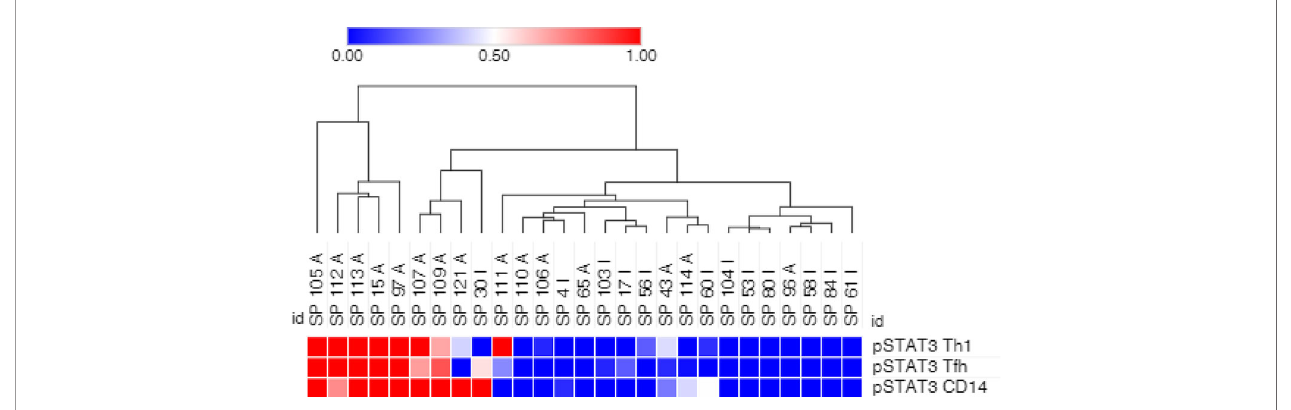
FIGURE 3 | pSTAT3 levels in Th1 and Tfh CD4+ T cells, and in CD14+ monocytes partially cluster PsA samples. Arcsinh transformed geometric mean of pSTAT3 phosphorylated target in Th1 and Tfh CD4+ T cells and CD14+ monocytes was used. Clustering by hierarchical clustering using Euclidean distance with average linkage. A, active PsA; I, inactive